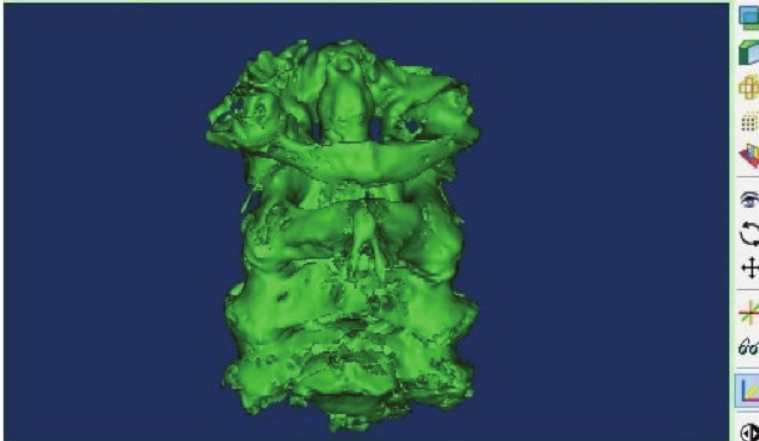
Medical Mimics Software Environment. This software is able to detect bone tissues according to the assumptions of the software, Fig. 1: and it can perform a three-dimensional reconstruction.